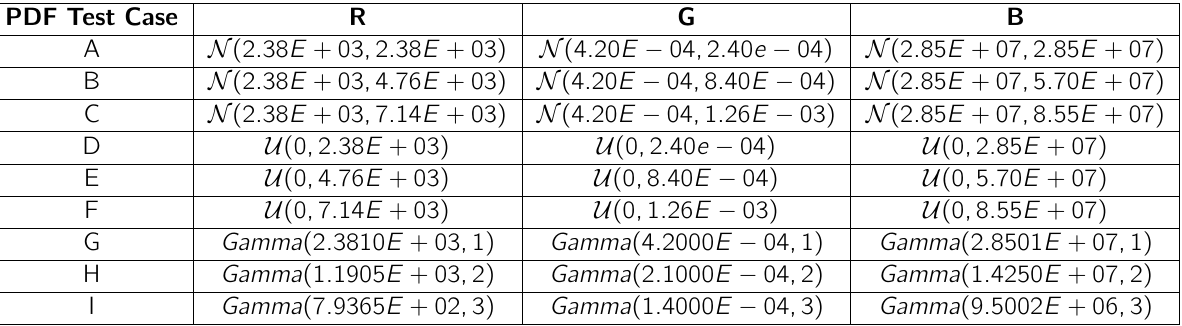
Table 1: The PDFs assumed for R , G and B .